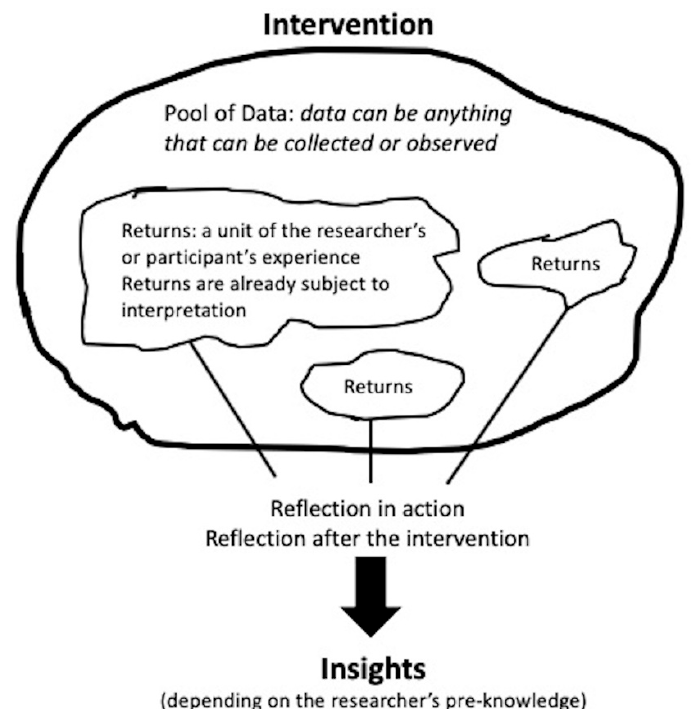
Figure 5. Diagram to visualize the relationship between data and returns. The researcher experienced the pool of data and collected returns whilst applying reflection-in-action and reflection after the intervention to draw out insights.